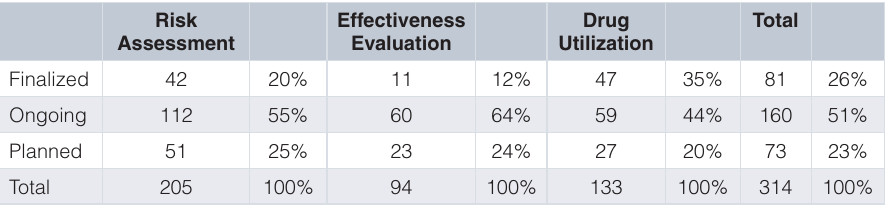
Table 1. Type of EMA requested PAS registered in ENCePP by 18 th October 2016 by study status (finalized, ongoing or planned). Risk